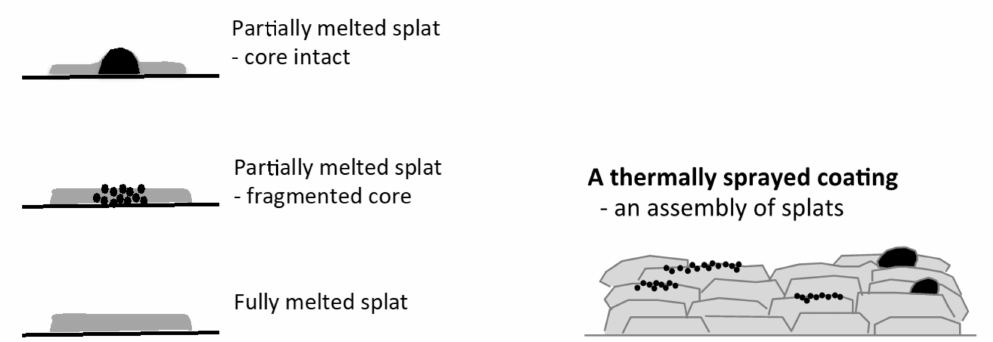
Figure 1. The variety of splats displaying the building block and their assembly in a thermal spray coating: a splat with a raised center from a partially melted particle, a micro-rough splat from a partially melted particle and a smooth splat from a melted particle. Black represents the unmelted particle